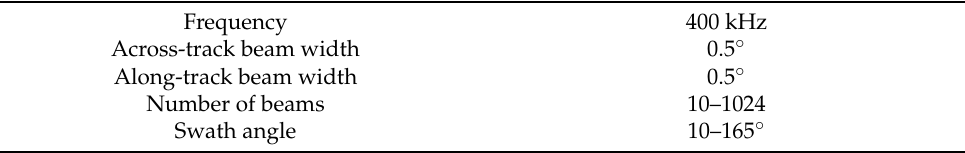
Table 1. Specification RESON T50 extended range.